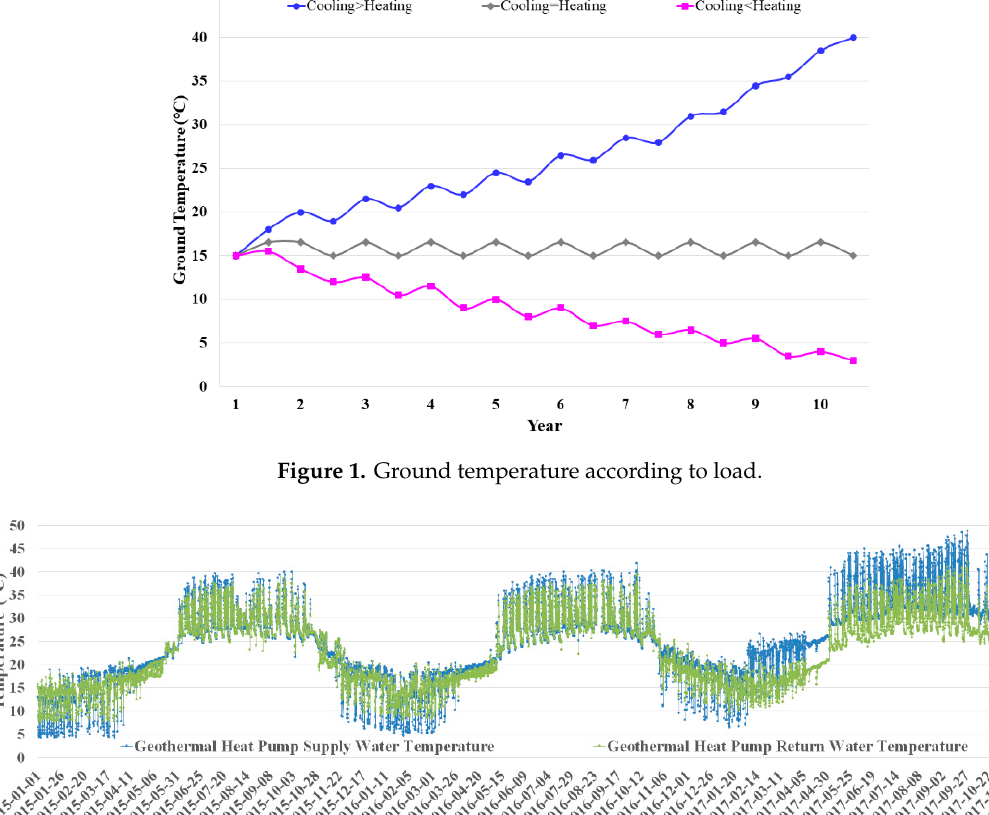
Figure 1. Ground temperature according to load.